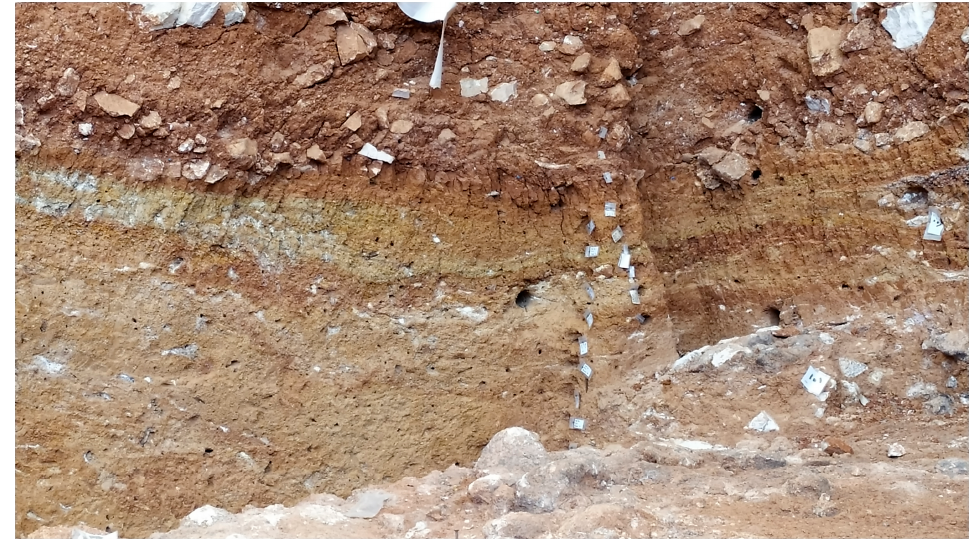
Figure 12. Detailed view of the TD9 unit and contact with TD10 (overlying breccias), showing the characteristic alternating colours and parallel lamination. characteristic alternating colours and parallel